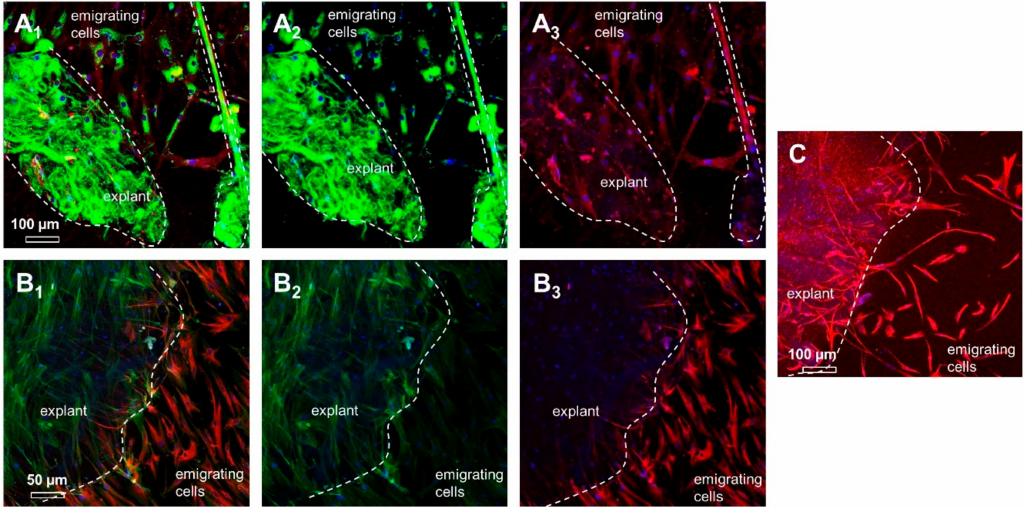
Figure 6. The expression profile in ITB explants and emigrating cells. ( A ) The main ligament extracellular matrix (ECM) protein collagen type I and the corresponding cell ECM adhesion receptor β 1-integrin are shown ( A 1 : merged, A 2 : collagen type I (green), and A 3 : β 1-integrin (red)). Dashed line: The explant and, on the right side, a thick bundle of collagen fibers are shown. ( B ) F-actin filament organization and synthesis of vascular endothelial growth factor A (VEGFA) in explants cultured for 5 weeks and emigrating cells ( B 1 : merged, B 2 : F-actin (green), and B 3 : VEGFA (red)). ( C ) The mesenchymal intermediate filament vimentin (red). Scale bars: Figure 6A,C: 100 µ m and Figure 6B: 50 µ